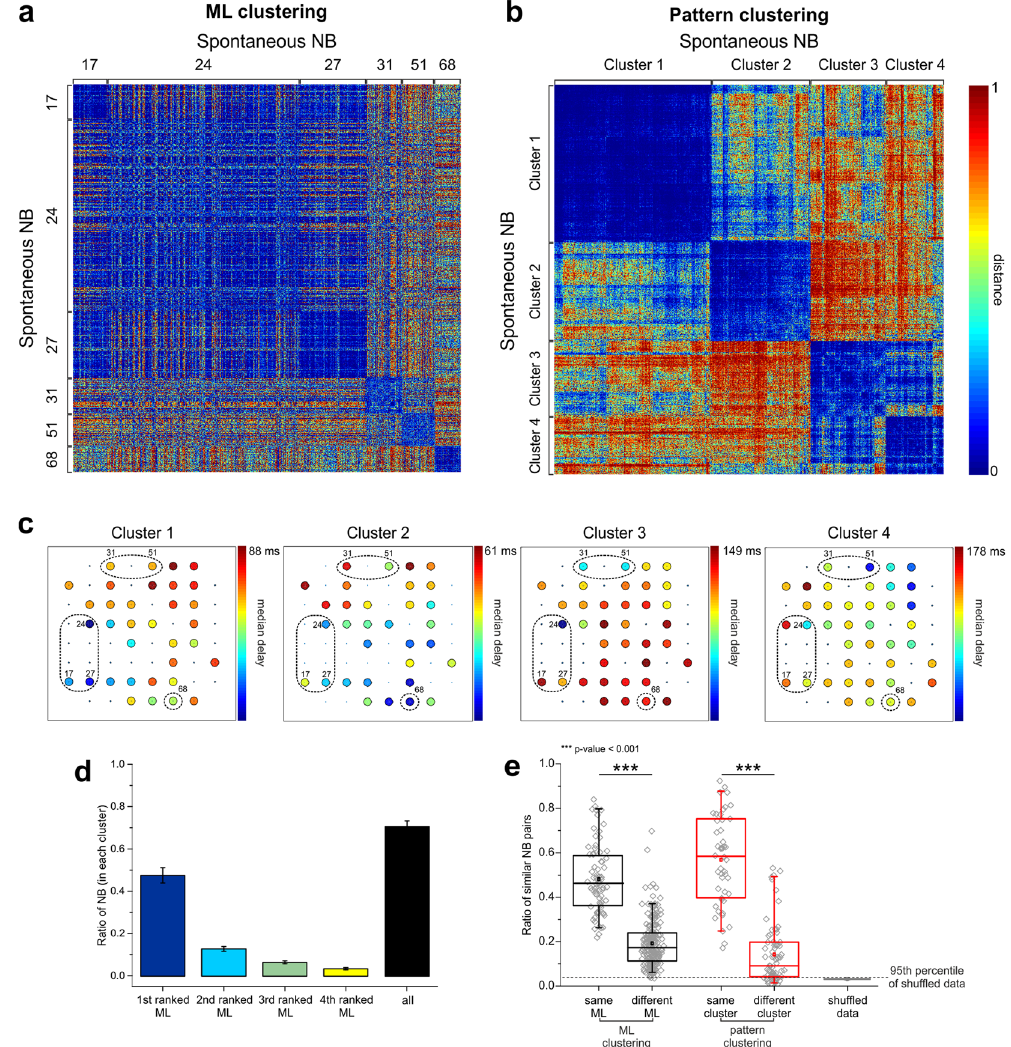
Figure 2. Diverse clusters of NB patterns are associated to different MLs. ( a ) Color-coded matrix of normalized distances between all pairs of spontaneous NBs (representative experiment) ordered by ML. ML numbers are reported aside, to indicate the corresponding clusters of NB. ( b ) Matrix of normalized distances between all pairs of spontaneous NBs, selected and ordered according to the pattern clustering procedure (same experiment as in a ). In this example, four separate clusters were identified. Cluster numbers are indicated aside. Color-map: cool colors indicate low distances, whereas warm colors indicate high distances. Range: [0, 1]. ( c ) Color-coded maps of median propagation delays of electrode activations (with respect to the leader) within each cluster of patterns identified in ( b ) (same experiment). Each color-map has been rescaled according to the maximum delay, as indicated in the figure. MLs are highlighted by the dashed circles. ( d ) Bar graph of the ratio of NBs led by the four top-ranked MLs found in each cluster (colored bars). The cumulative ratio of NBs led by the four top-ranked MLs is shown in the black bar (mean ± s.e.m., full dataset). ( e ) Ratio of significantly similar NB patterns driven by the same or different MLs (black), and of similar patterns belonging to the same cluster or different clusters (red). Box plots collect data from the full dataset. The ratio of significantly similar patterns occurring by chance in case of shuffling (cf. Supplementary Methods) is reported in the grey box plot (the 95 th percentile of shuffled data is indicated by the dashed line). Statistically significant differences as indicated in the figure have been assessed by Mann-Whitney U-test, > = p U 0